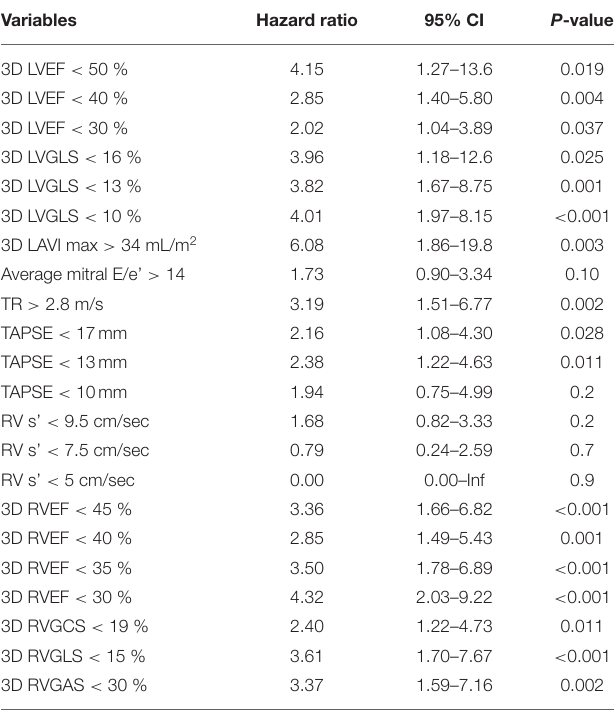
TABLE 4 | Univariate cox proportional hazards analysis with dichotomous variables for HF hospitalization.